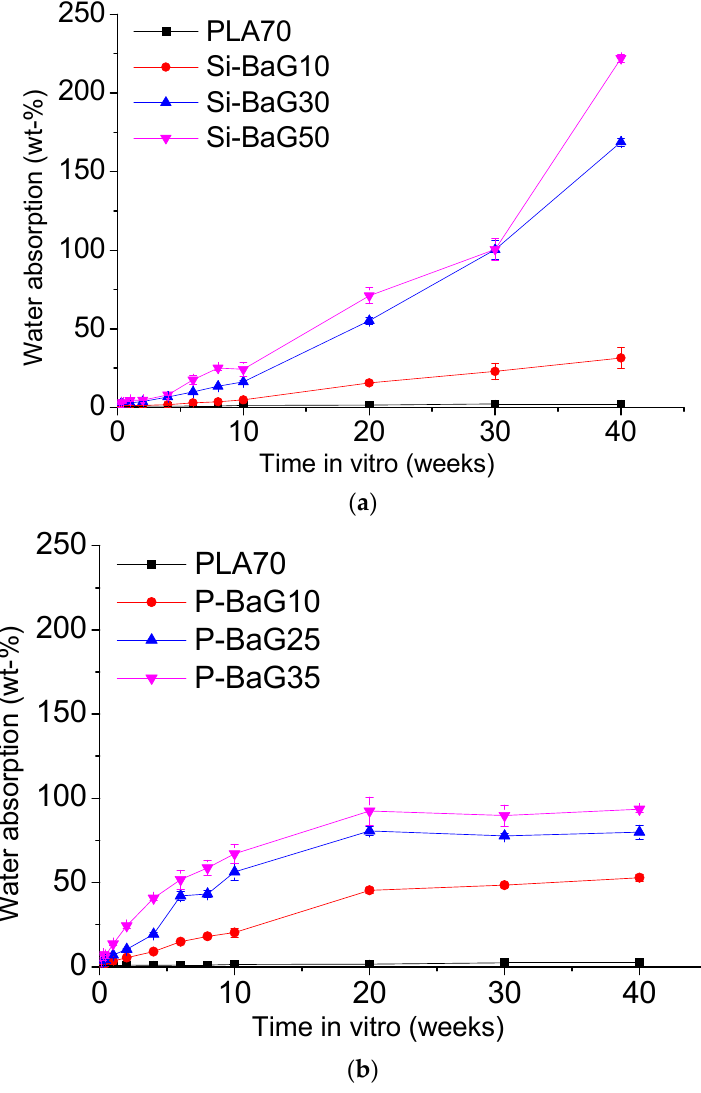
Figure 4. Water absorption of ( a ) Si-BaG and ( b ) P-BaG composites in Tris over 40 weeks. The water absorption of the PLA70 alone was negligible (2 wt.%) over the 40 weeks. PLA70 is a hydrophobic material, and these results are in line with previous research [15,22,26]. The Si-BaG10, Si-BaG30, and Si-BaG50 composites absorbed up to 32, 169, and 222 wt.%